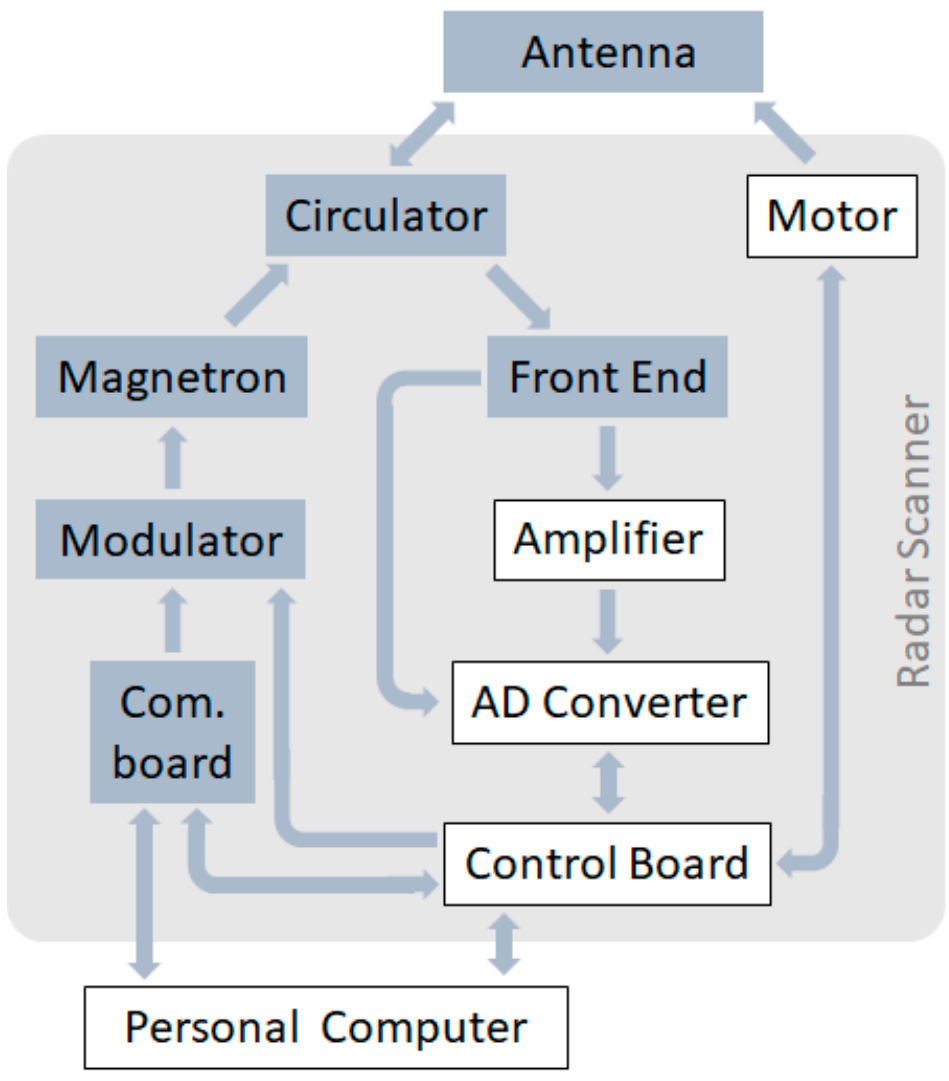
Figure 2. Block diagram of HZG’s coherent on receive MR. All grey shaded boxes are original units from the GEM radar; all white boxes represent custom made add ons to the system.